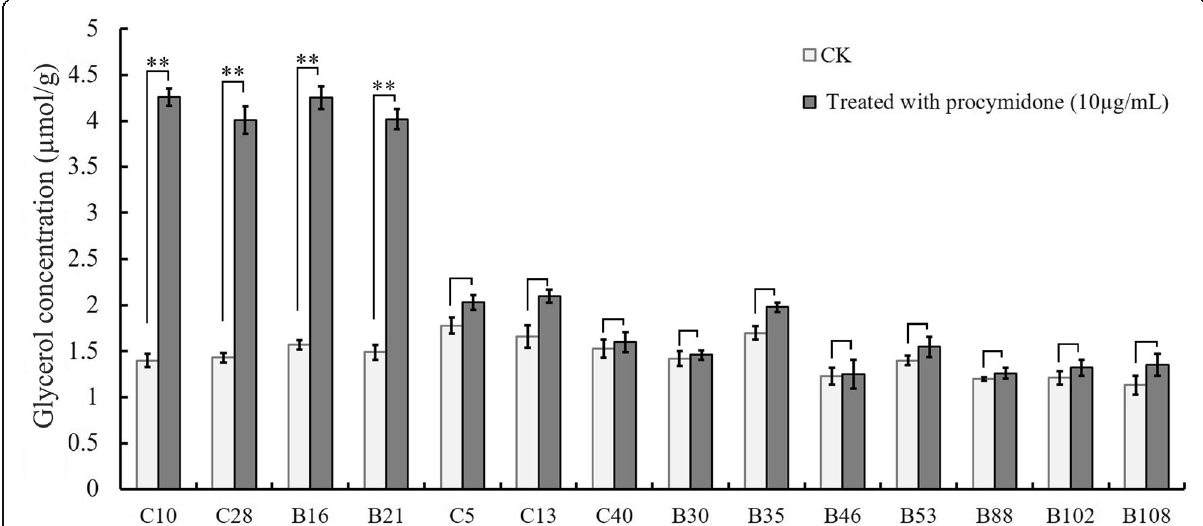
Fig. 4 Comparison of mycelial intracellular glycerol accumulations (MIGAs) among A. alternata Pro S and Pro HR isolates . The mycelia of each isolate were treated with procymidone at 0 or 10 μ g/mL after growth in PDB for 5 h. Bars denote the standard errors of three repeated experiments. The asterisk indicates significant difference between procymidone-treated sample and control. The Pro S isolates include C10, C28, B16 and B21. The Pro HR isolates include C5, C13, C40, B30, B35, B46, B53, B88, B102 and B108